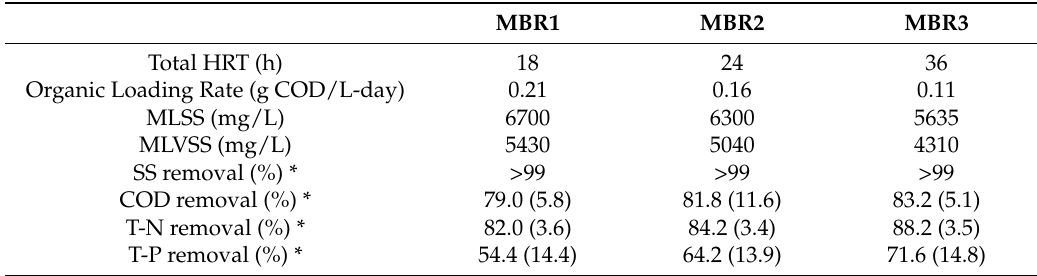
Table 3. Performance MLE type